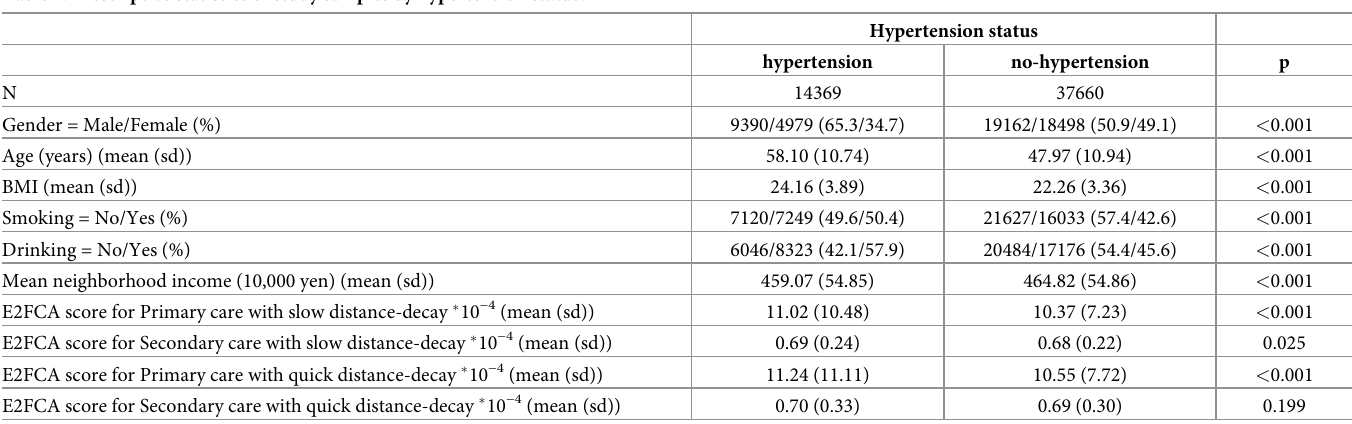
Table 1. Descriptive statistics of study samples by hypertension status.